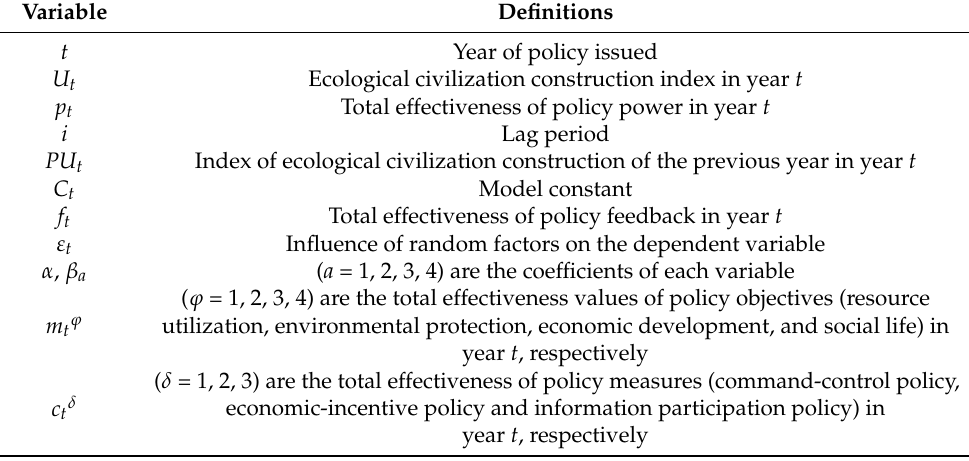
Table 2. Variable